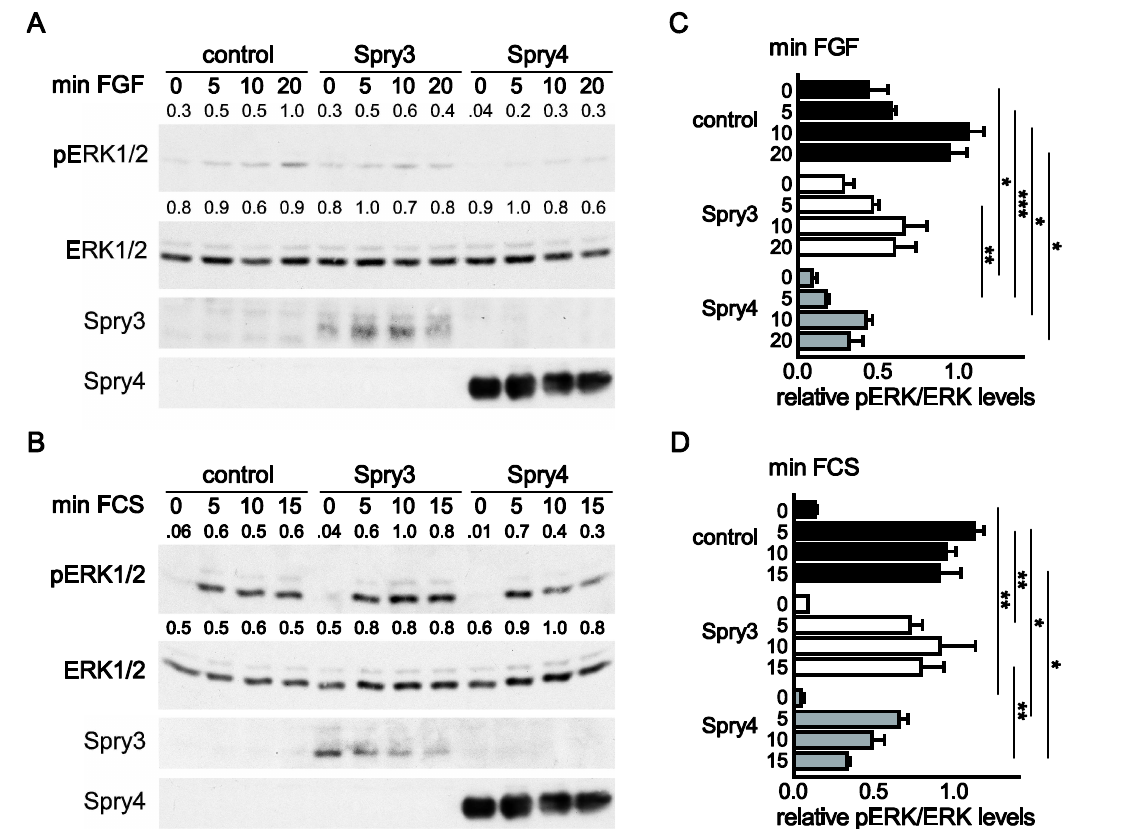
Figure 3. Influence of Spry3 and Spry4 proteins on ERK activation by FGF2 and serum. Glioblastoma (GBM)-derived cells (U373) were serum-starved for 24 h and then infected with adenoviruses expressing either a control protein (luciferase), Spry3 or Spry4. Two days later, cells were incubated with FGF2 ( A ) or serum ( B ) for the indicated times. Representative immunoblots of an experiment using antibodies recognizing pERK1 / 2 and total ERK1 / 2 are shown. Expression of Spry3 and Spry4 were verified by the respective antibodies. Using ImageQuant 5.0, the pERK1 / 2 bands detected were quantified and normalized to the corresponding values obtained for the ERK expression. The highest values were arbitrarily set as 1. The results of the quantification for the presented blots are depicted. ( C ) A summary of calculated mean values ± SEM of the pERK/ERK values from three experiments